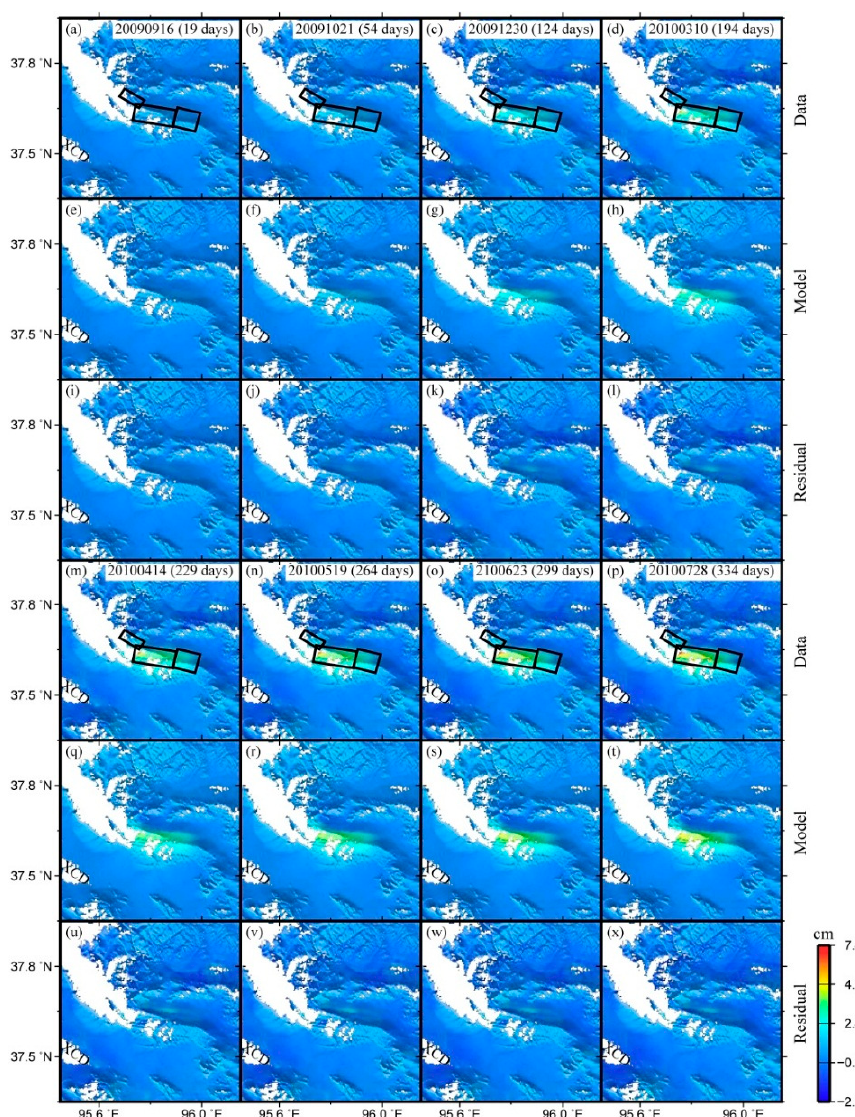
Figure 2. ( a – d ) Observed postseismic deformation time series at the first four time epochs of InSAR observations [23]; ( e – h ) Modeled postseismic deformation time series from the combination model of afterslip and viscoelastic relaxation; and ( i – l ) residual deformation time series by subtracting ( e – h ) from ( a – d ); ( m – x ) are for the last four time epochs of InSAR observations [23]. The dates and days after the 2009 Mw 6.3 DCD earthquake are labeled at the top-right of subfigures ( a – d ) and ( m – p ). XCD is the abbreviated form of Xiaochaidan. Positive and negative values indicate motions toward and away from the satellite in the line-of-sight (LOS) direction, respectively.